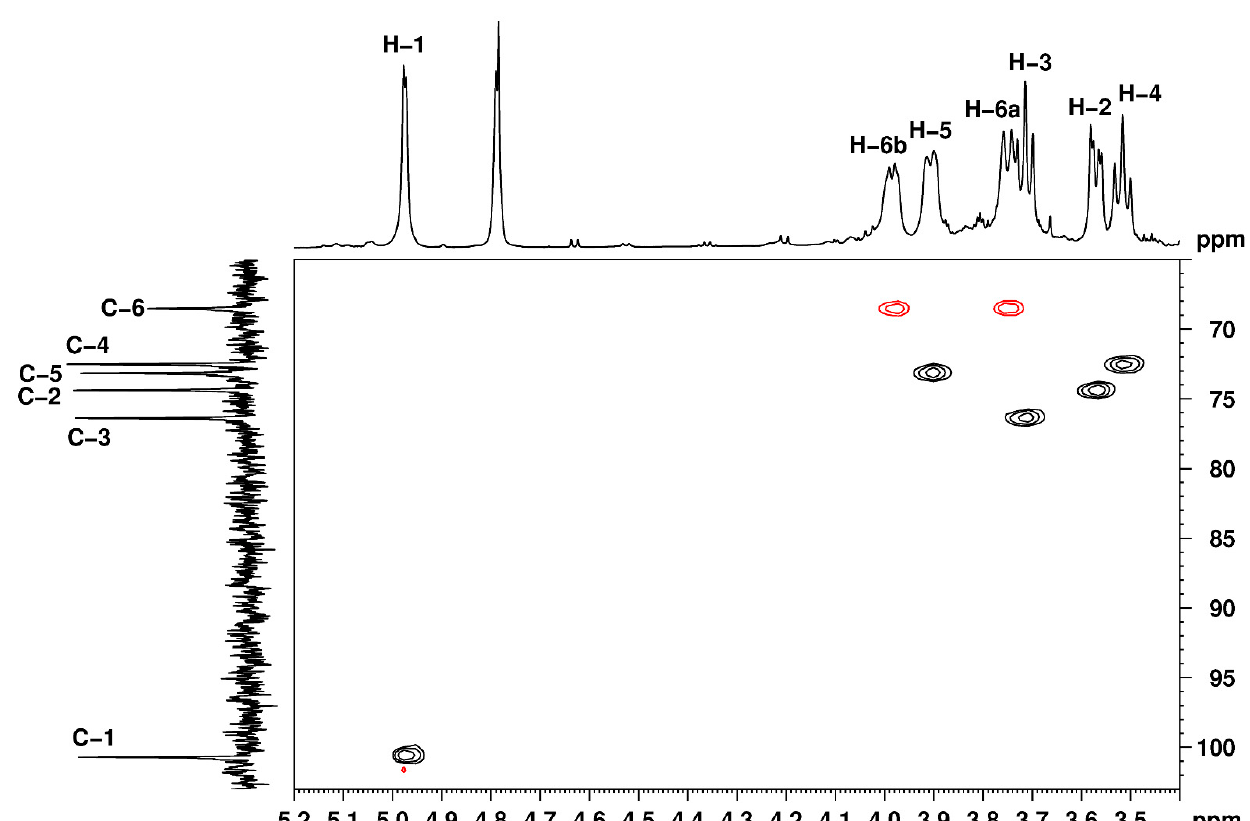
Figure 6. Multiplicity edited H, C HSQC spectrum corresponding to samples M3C4, showing the correlation signals associated with a proton ‐ carbon direct chemical bond. The methylene group is clearly identified based on the negative phase (colour code red).